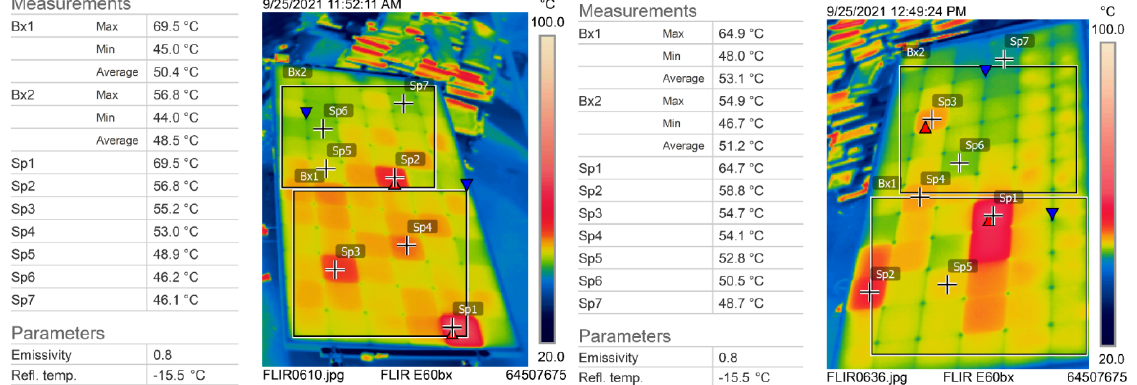
Figure 22. Thermographic analysis of module number 5 ( left ) and module number 6 ( right ).